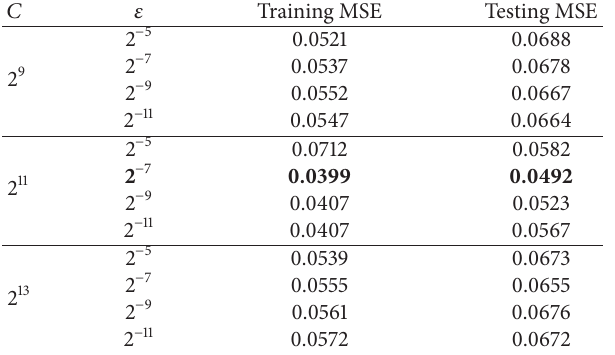
Table 3: Model selection results of the sICA-SVR model.